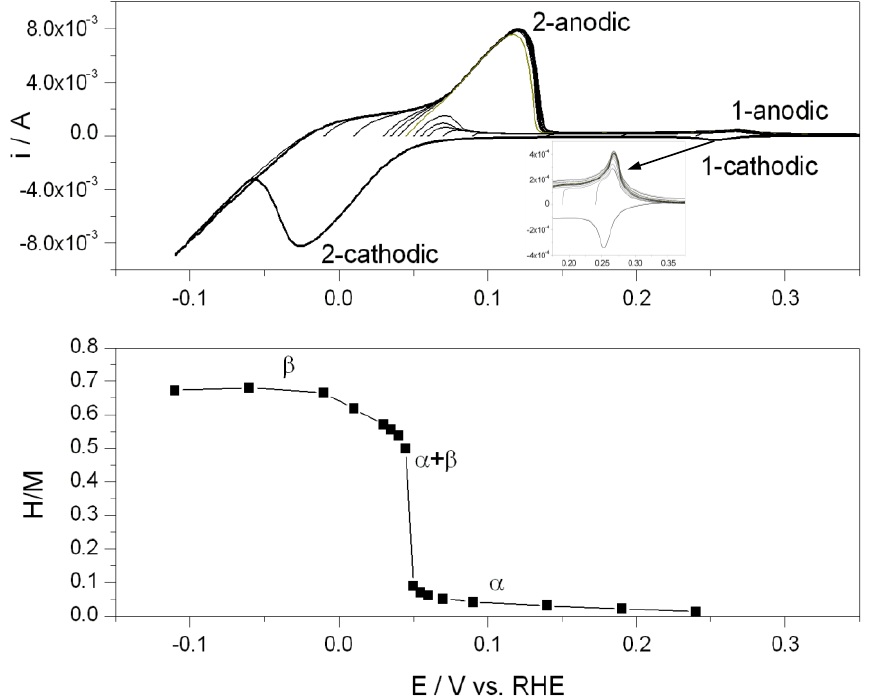
Figure 1. Cyclic voltammograms recorded in the potential region of hydrogen electrosorption in a 88.9% Pd–3.4% Pt–7.7% Au alloy for various lower potential limits (scan rate 0.01 V s −1 , temperature 298 K) together with a the hydrogen-to-metal atomic ratio (H/M) vs. potential dependence obtained from hydrogen oxidation charges after integration of anodic voltammetric currents.